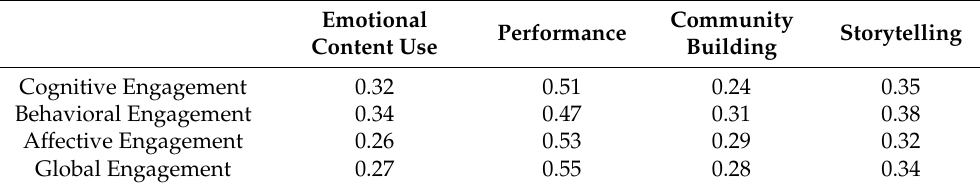
Table 7. Correlations between measures of faculty engagement and student engagement.